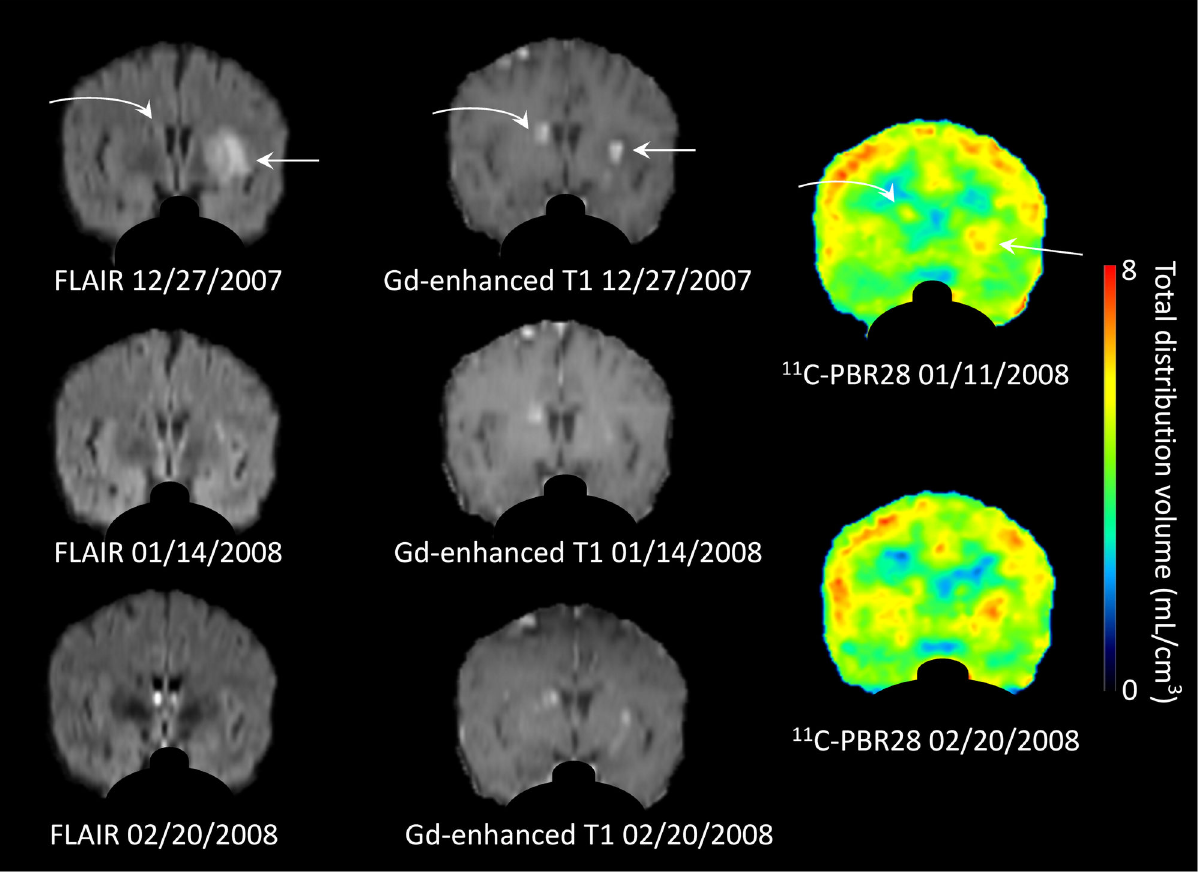
Figure 2. MR and PET images of patient 1 following a single perilesional edema episode. Fluid-attenuated inversion recovery (FLAIR) and gadolinium (Gd)-enhanced T1-weighted MR images at three time points and 11 C-PBR28 PET images obtained at two time points. Two lesions are seen, the straight arrow points out a calcification with edema in the left basal ganglion and the curved arrow the edema and calcification in the right centrum semiovale. Although perilesional edema resolved by 01/14/2008, 11 C-PBR28 PET uptake was still present. PET images show 11 C-PBR28 binding in total distribution volume, V show the two lesions on the same coronal slice. Images outside of brain parenchyma are masked. doi: